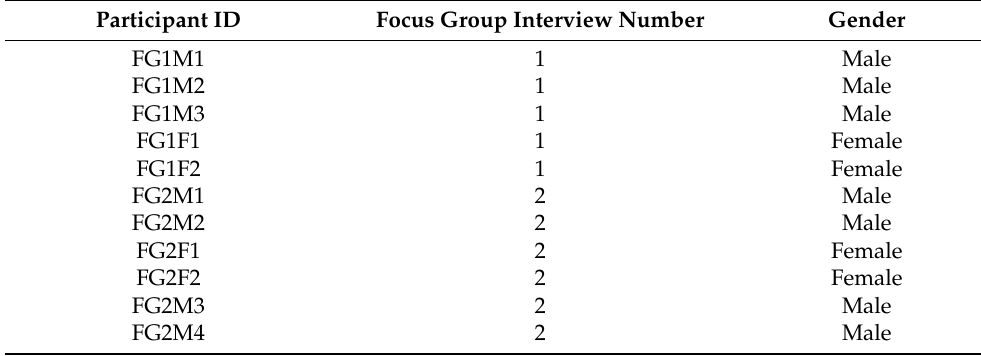
Table 1. Simple overview of the participants. FG = Focus group, F = Female, M = Male.